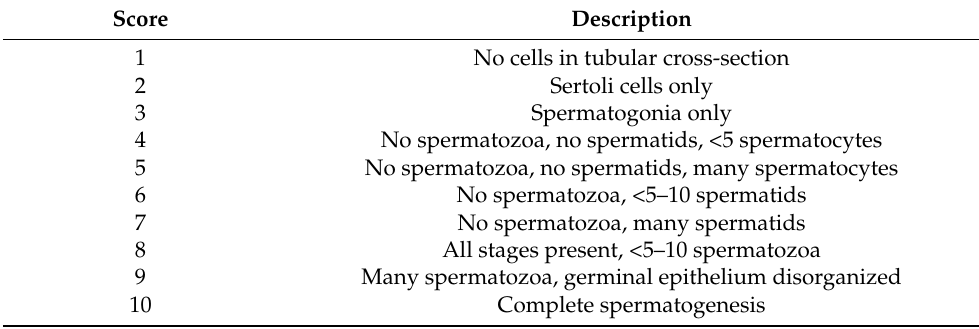
Table 1. A scoring system, designed to quantify the degree of spermatogenesis.